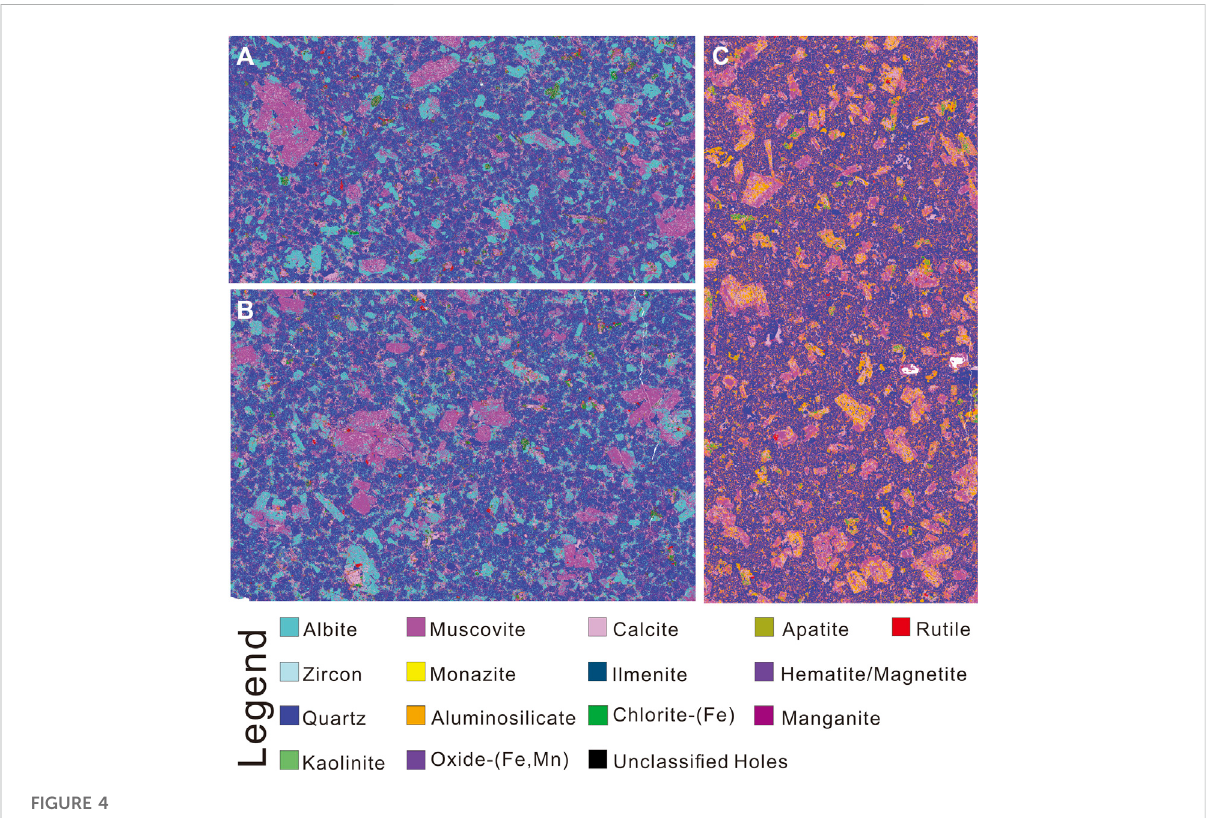
FIGURE 4 TIMA results of the newly identi fi ed granitic